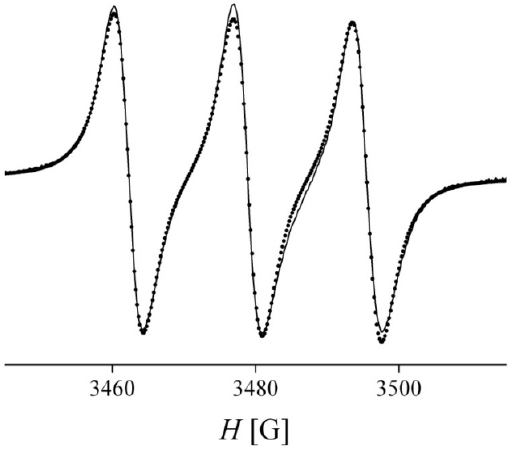
Figure 3. Electron magnetic resonance (EPR) spectra of TEMPOL radical in magnetoisotropic gel ( f = 9.763559 GHz). Dots: experimental spectrum. Solid line: theoretical description by the Anderson line.